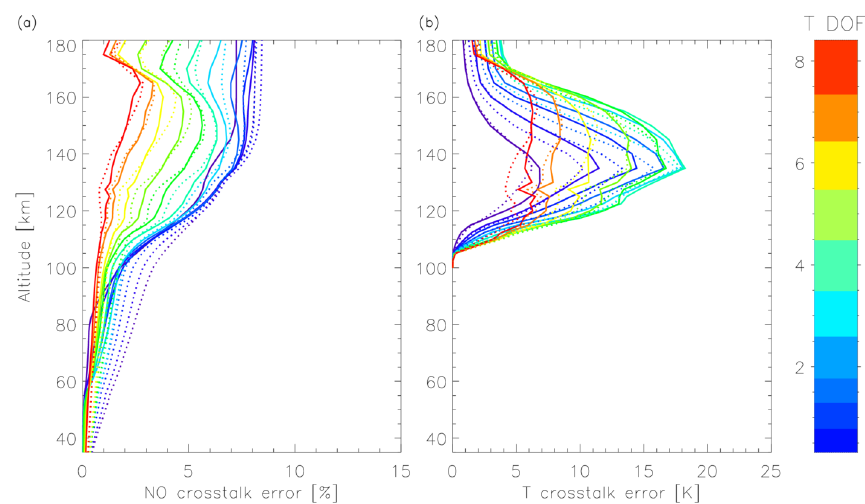
Figure 4. Crosstalk of the temperature-smoothing error in the NO results (a) and vice versa (b) in 5.3µm UA retrievals as a function of the obtained degree of freedom of the retrieved temperature profile. Resultant error contributions are shown separately for daytime (solid) and nighttime (dotted)